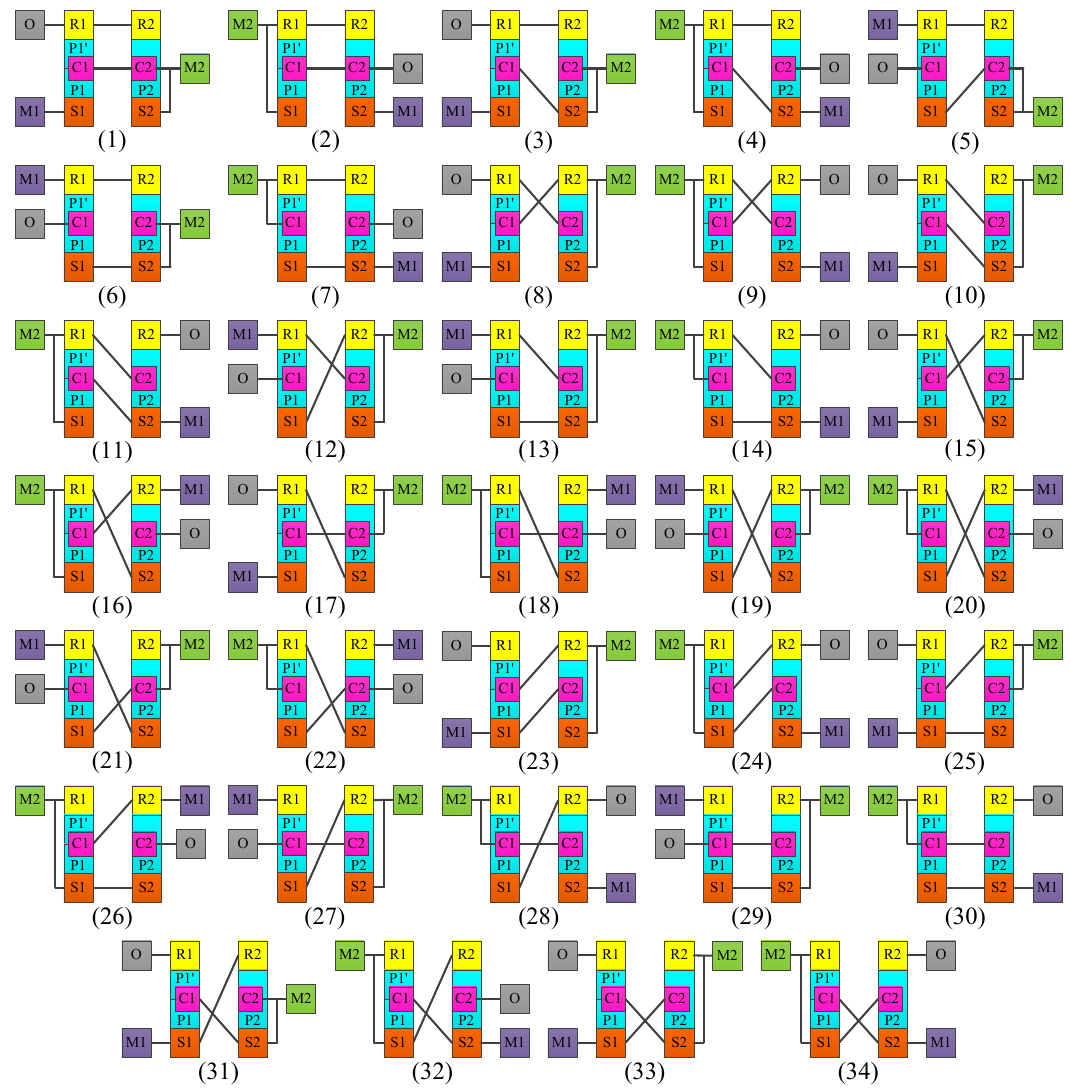
Figure 6. Atlas of the new motor transmissions without clutch.